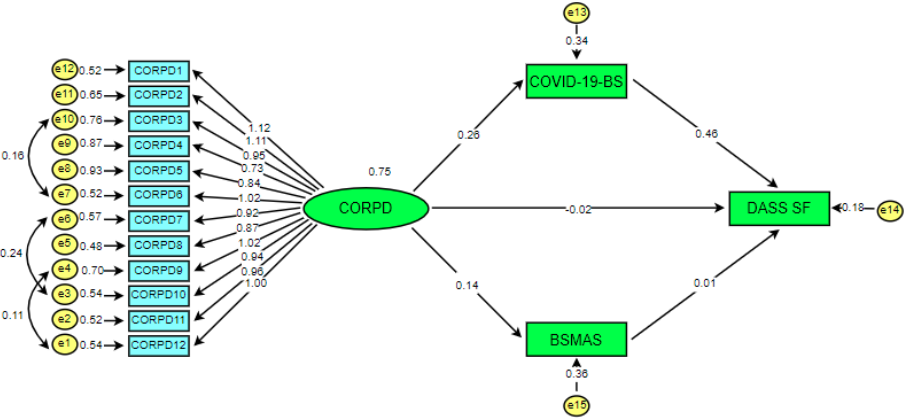
Figure 2. Final hypothesized model used in the research scenario.